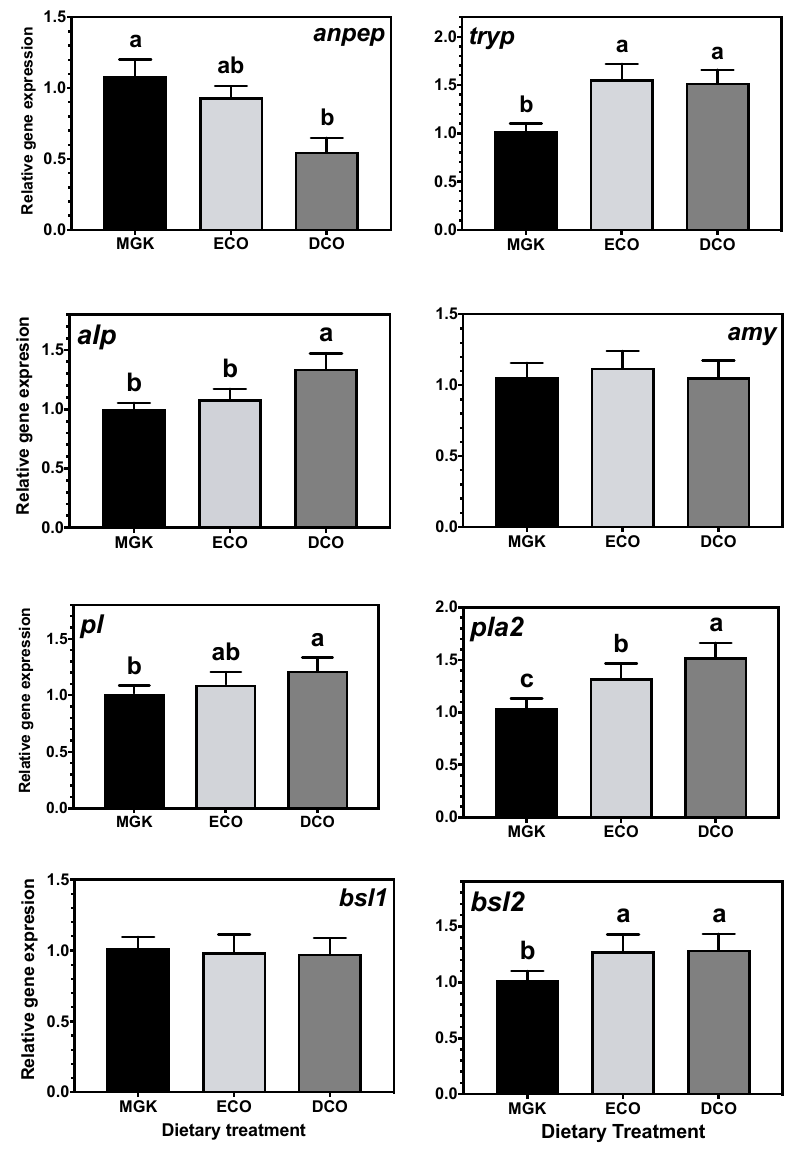
Figure 8. Nutritional regulation of amino peptidase ( anpep ), trypsin ( tryp ), alkaline phosphatase ( alp ), amylase ( amy ), pancreatic lipase ( pl ), phospholipase A2 ( pla2 ), bile salt activated lipase 1 ( bsl1 ) and bile salt activated lipase 2 ( bsl2 ) digestive enzyme gene transcription in intestine of Atlantic bluefin tuna ( Thunnus thynnus L.) juveniles fed a reference diet Magokoro ® (MGK) and two test diets containing either EPA (ECO) or EPA + DHA (DCO) oils from transgenic Camelina sativa seeds. Values are normalised expression ratios to MGK reference diet and are means ± SD ( n = 6). Values with different superscript letters are significantly different (one-way ANOVA and Tukey test; p < 0.05).